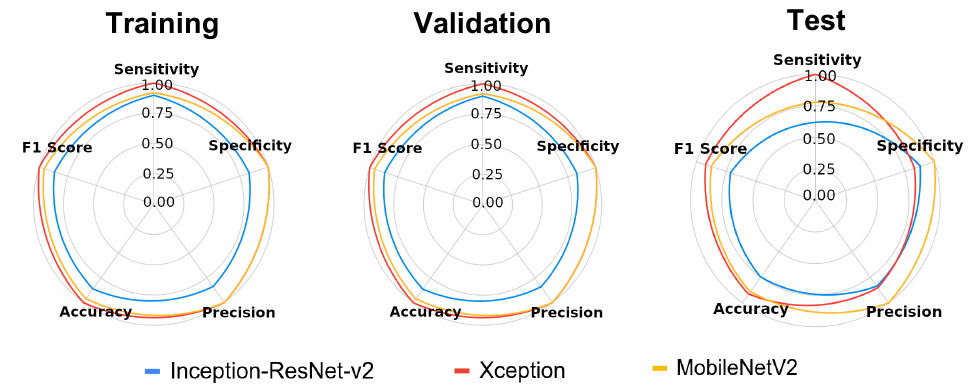
Figure 7. Star plot for the metrics of the Inception-ResNet-v2, Xcep-tion and MobileNetV2 architecture models tested for classification of radiographic images from maize grains infested and not infested with Sitophilus zeamais .